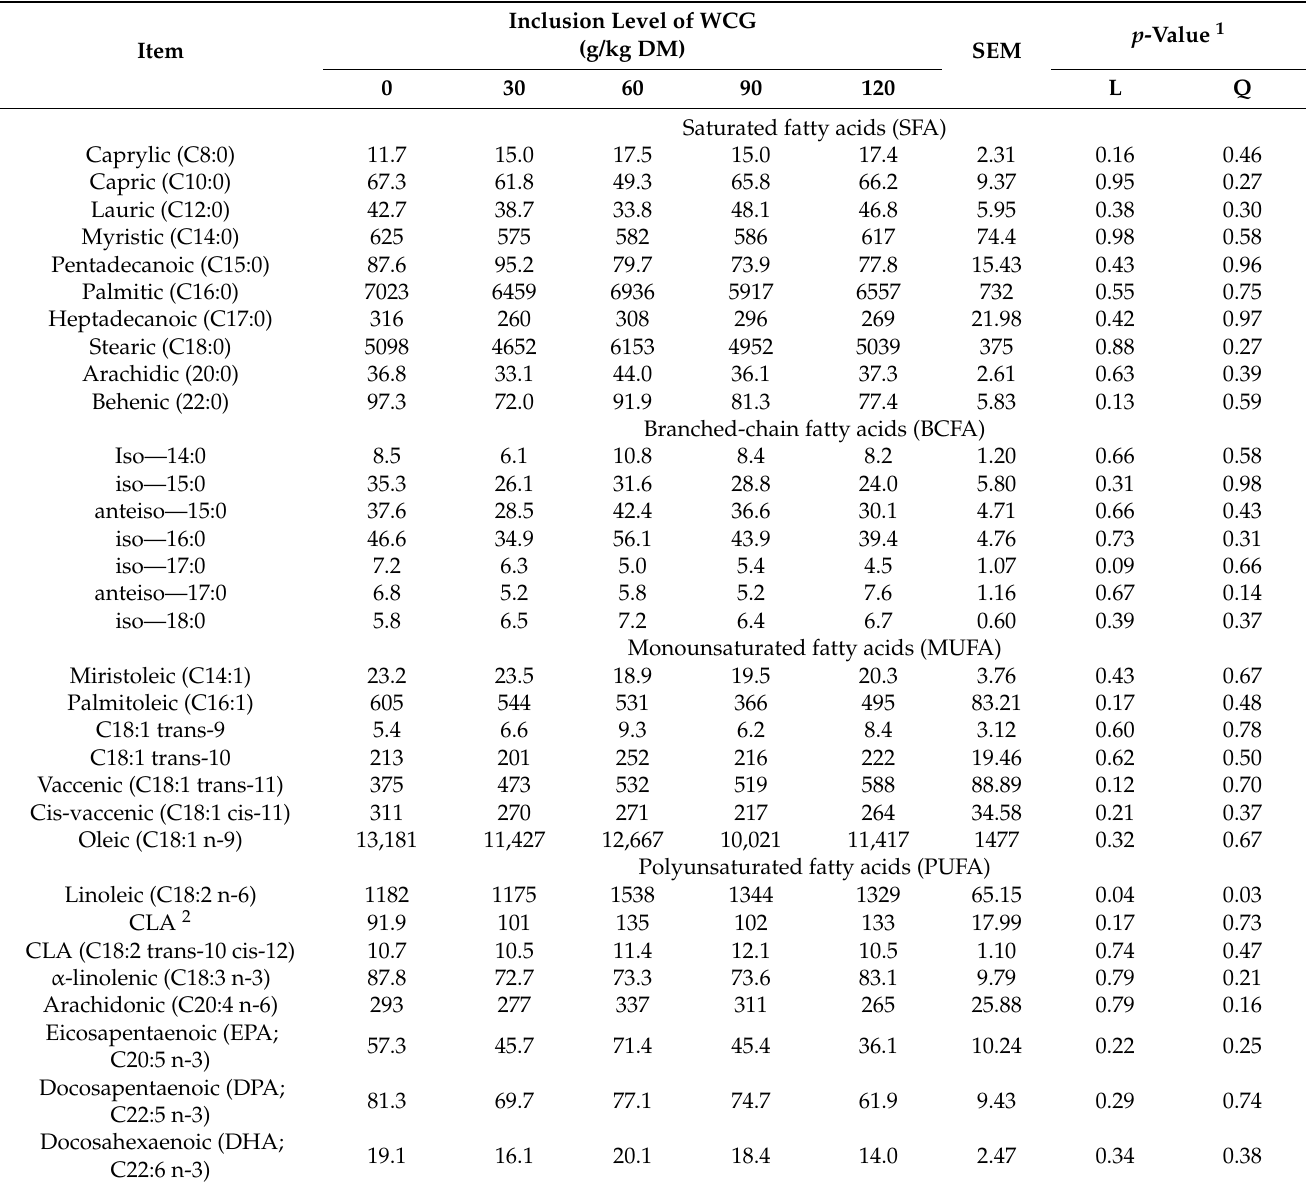
Table 4. Fatty acid composition (mg/kg of meat) of the Longissimus lumborum muscle of feedlot lambs fed diets with whole corn germ